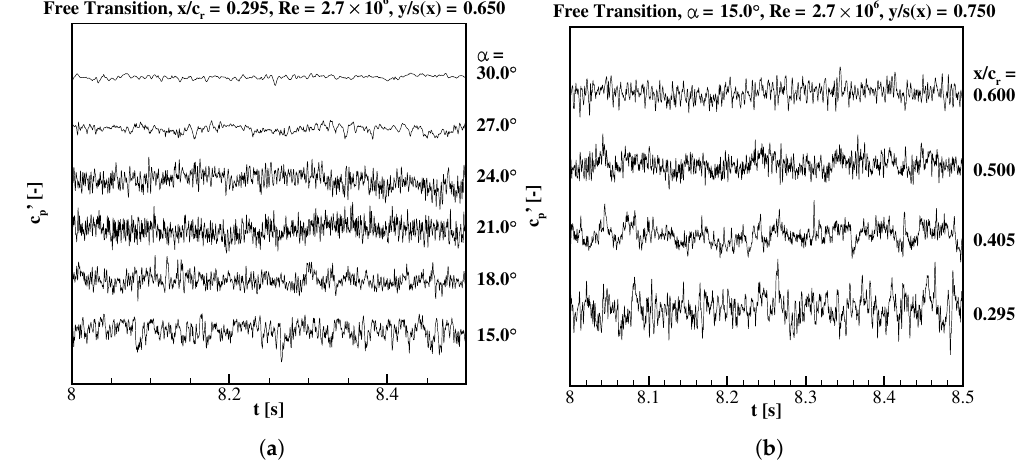
Figure 13. Pressure coefficient time sequences for the free transition case measured at ( a ) x / c r = 0.3, y / s ( x ) = 0.65 with increasing angle of attack, α = [ 15 ◦ ,18 ◦ ,21 ◦ ,24 ◦ ,27 ◦ ,30 ◦ ] ; and at ( b ) four different chordwise locations, x / c r = [ 0.3,0.4,0.5,0.6 ] , y / s ( x ) = 0.75, at an incidence of α = 15 ◦ ; Re = 2.7